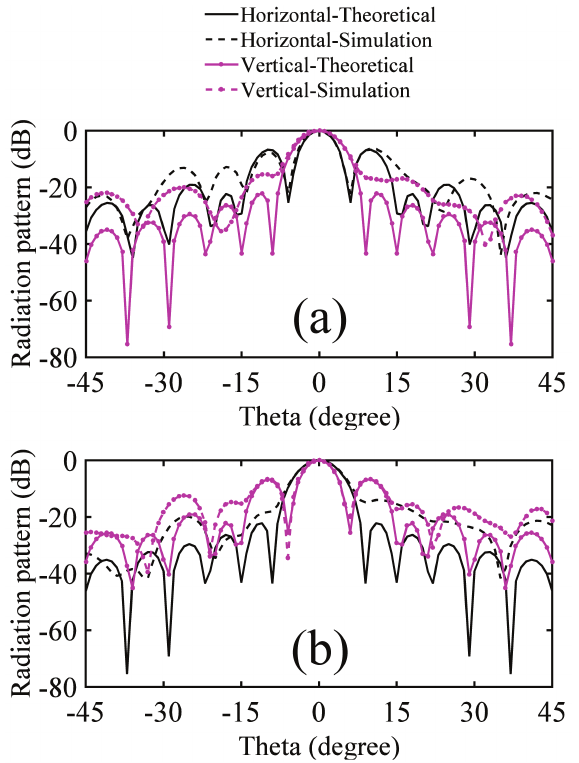
Figure 7: Radiation components of the designed reflectar- ray antenna at 10 GHz. (a) ϕ = 0 . (b) ϕ = 90 .